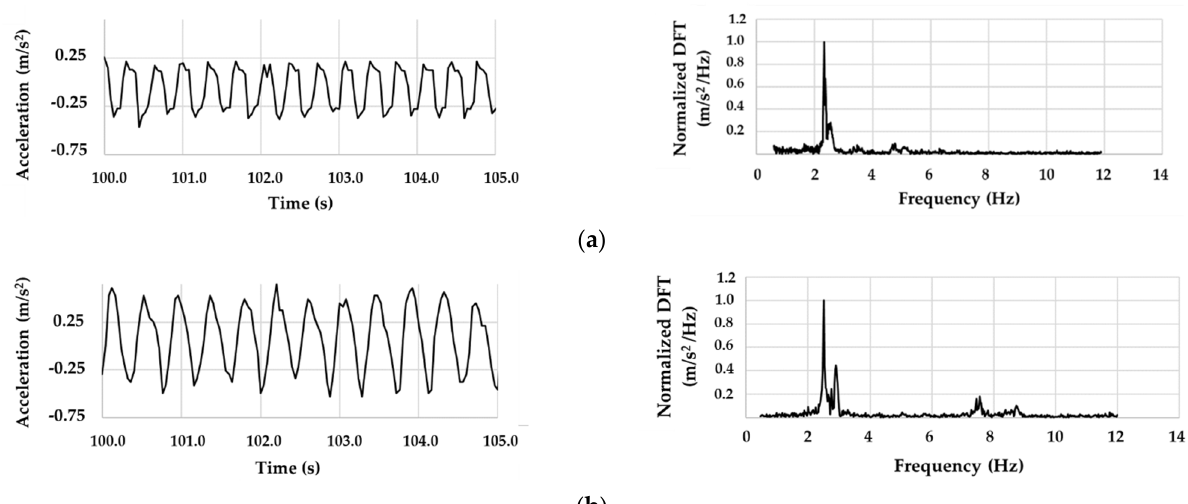
Figure 4. Comparison between acceleration and normalized DFT ( a ) at sea and ( b ) in artificial channel.